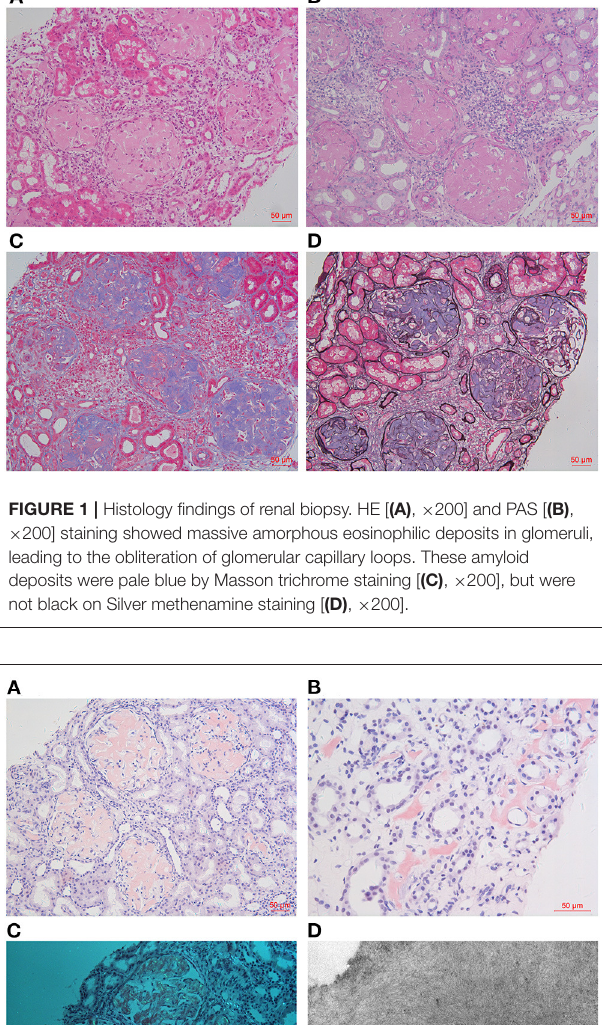
24 h, serum albumin of 28.8 g/L, serum creatinine of 182.3 µ mol/L. Plasma fibrinogen (reference: 1.5–4 g/L) was normal. No evidence of a monoclonal protein was found in serum or urine.